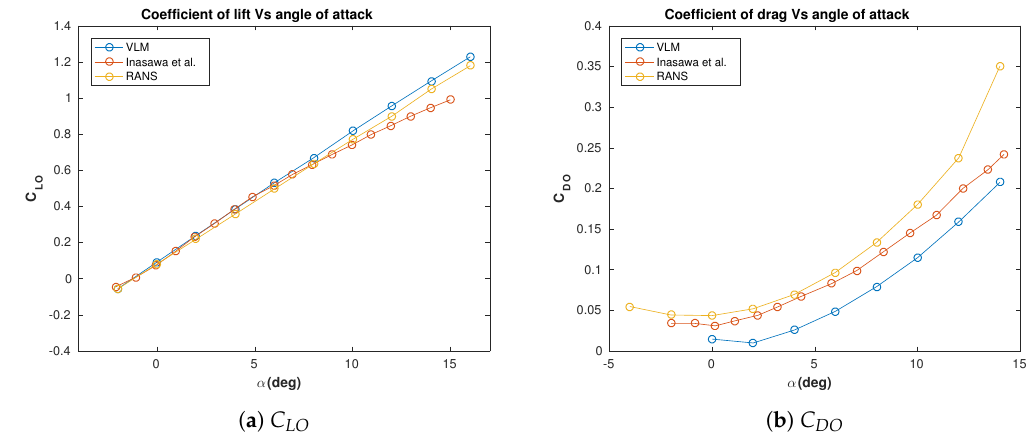
Figure 7. Polar analysis of isolated NACA23012 wing plotting for coefficient of lift ( C LO ) and drag ( C DO ); results include VLM, RANS and experiment from Inasawa et al. [10].